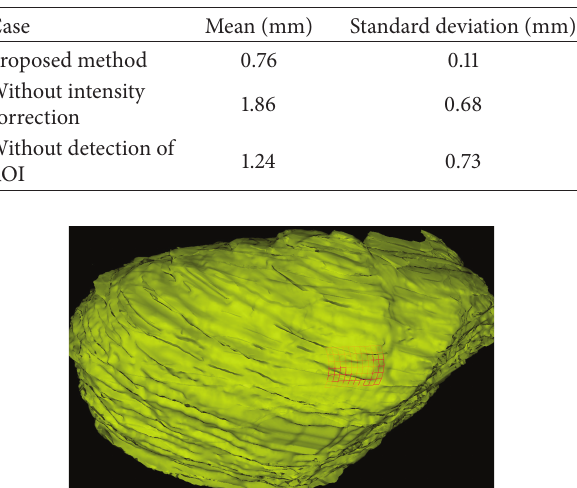
Table 2: Average surface distance error (ASD) impacted by image processing procedures.